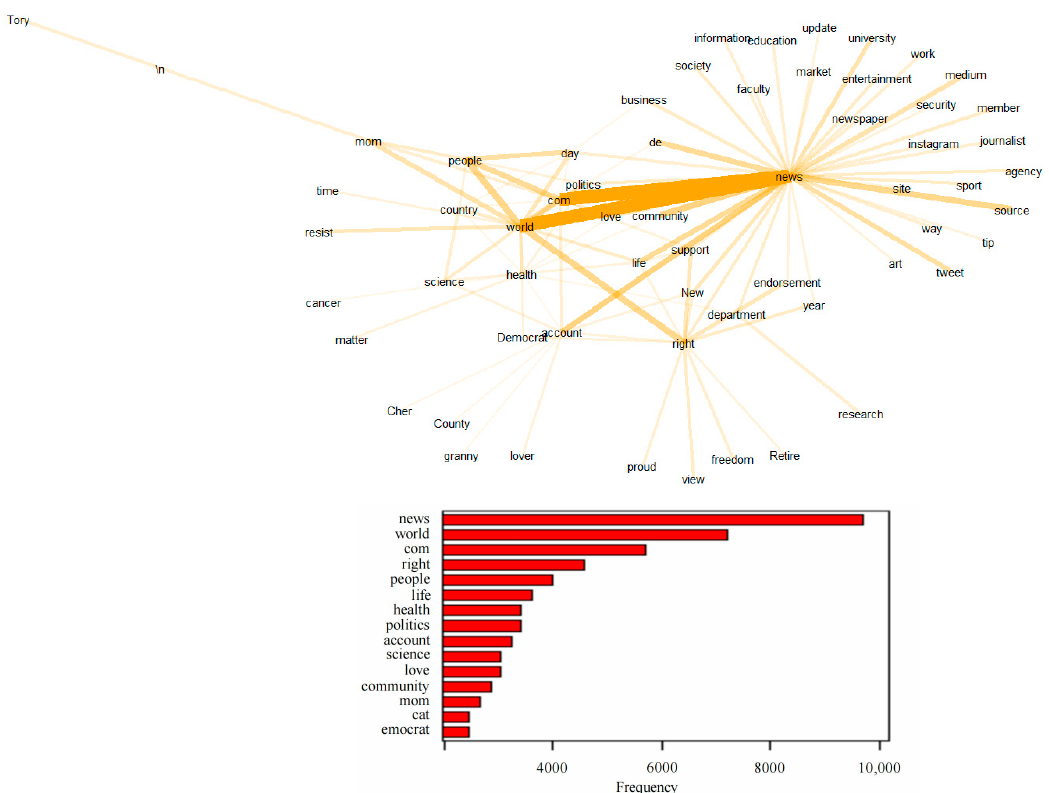
Figure 9. Word collocation of social bot accounts’ profile.